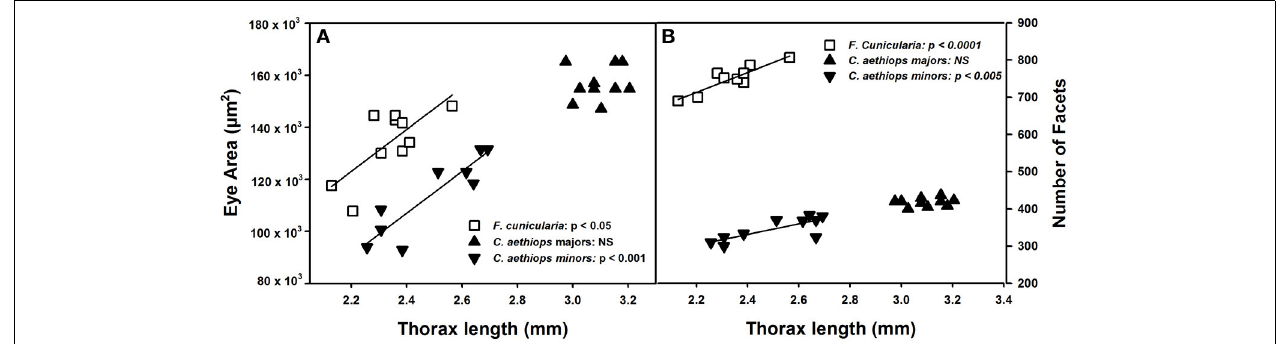
majors. (B) The number of eye facets increased significantly thorax length in F. cunicularia and C. aethiops minors but not in C. aethiops majors. NS, not